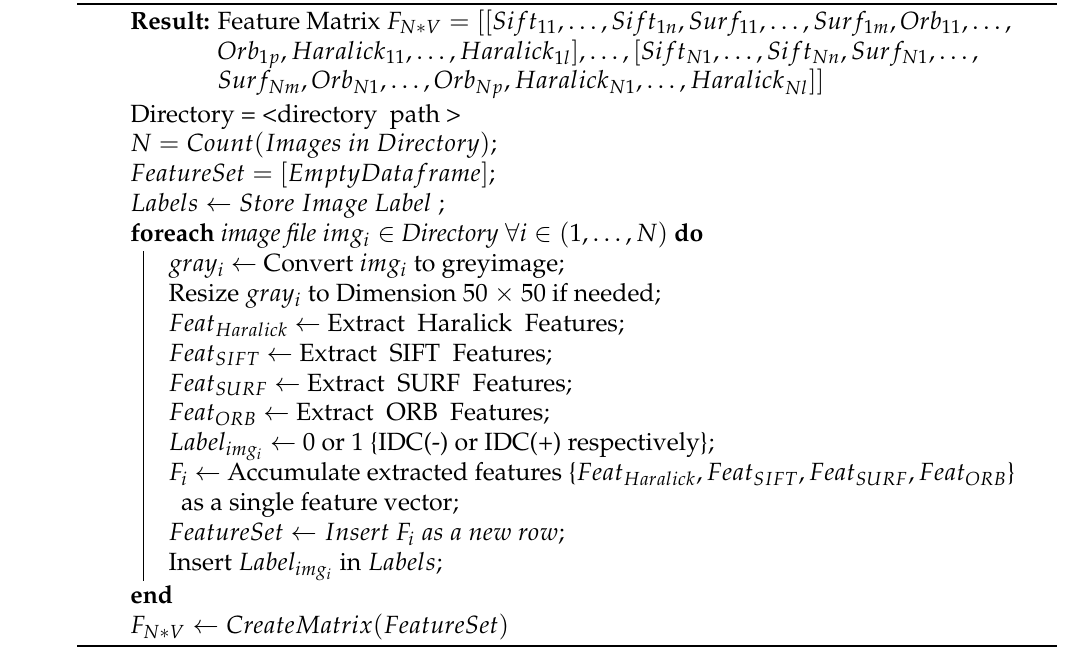
Algorithm 1: Extract the SIFT, SURF, ORB and Haralick